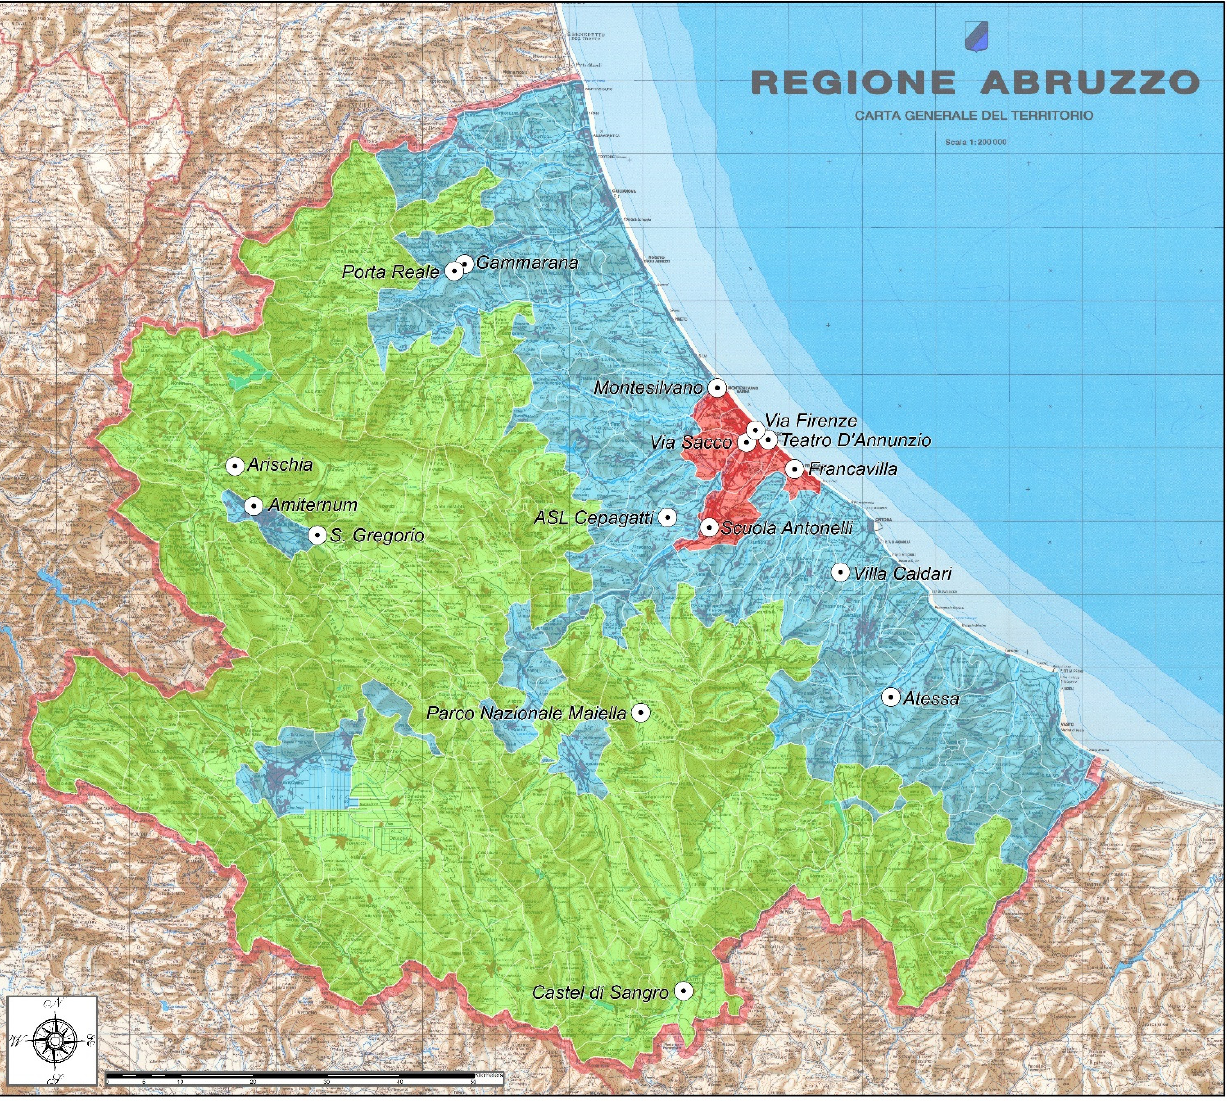
Figure 2. Air quality monitoring stations in the coastal area of Abruzzo (central Italy). List of the names of the monitoring stations: Sacco (SA), Firenze (FI), Montesilvano (MO), Scuola Antonelli (CH) Francavilla (FR), Amiternum (AQ), S. Gregorio (SG), Gammanara (GA), Porta Reale (PR), Cepagatti (CE) Villa Caldari (OR), Atessa (AT), Castel di Sangro (CS), Arischia (AR), Parco N zionale Maiella (PNM)